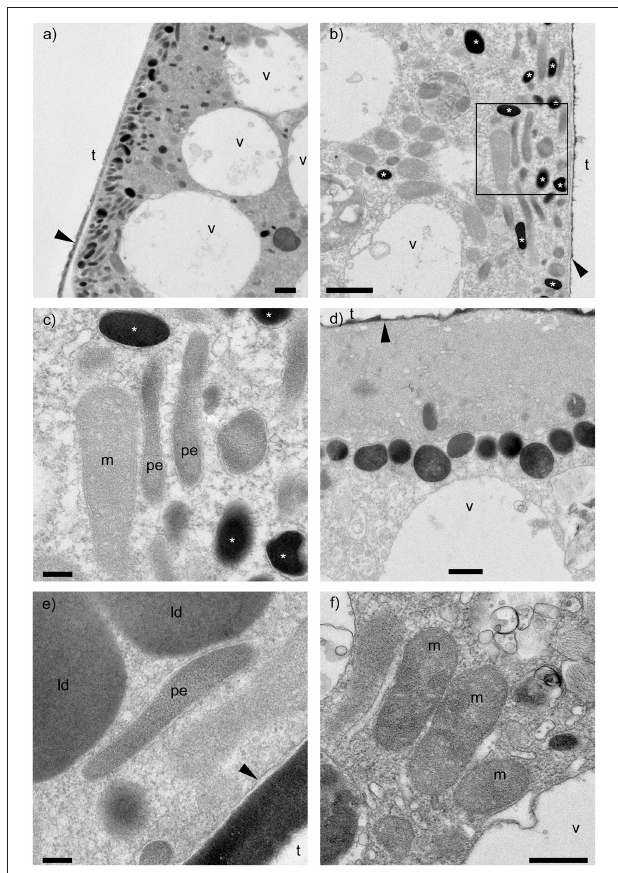
FIGURE 1 | Transmission electron micrographs of Ammonia sp. incubated with anoxic conditions. (A,B) Clusters of electron dense bodies (*) found near the cell periphery of the antepenultimate and penultimate chambers, respectively. (C) Close-up view of outlined area in b showing electron dense bodies ( * ), most bound by membrane. (D) Electron dense bodies showing heterogeneous electron densities. (E) Close-up view of a possible endobiont surrounded by membrane. (F) Mitochondria showing double exterior membrane. m, mitochondria; pe, possible endobionts; v, vacuoles; t, test (former location); ld, lipid droplet; black arrows, organic lining. Scale bars: (A,B) = 1 µ m; (C,E) = 200nm; (D,F) = 500nm. Panels (A–C,F) : anoxic specimen A; panels (D,E) : anoxic specimen